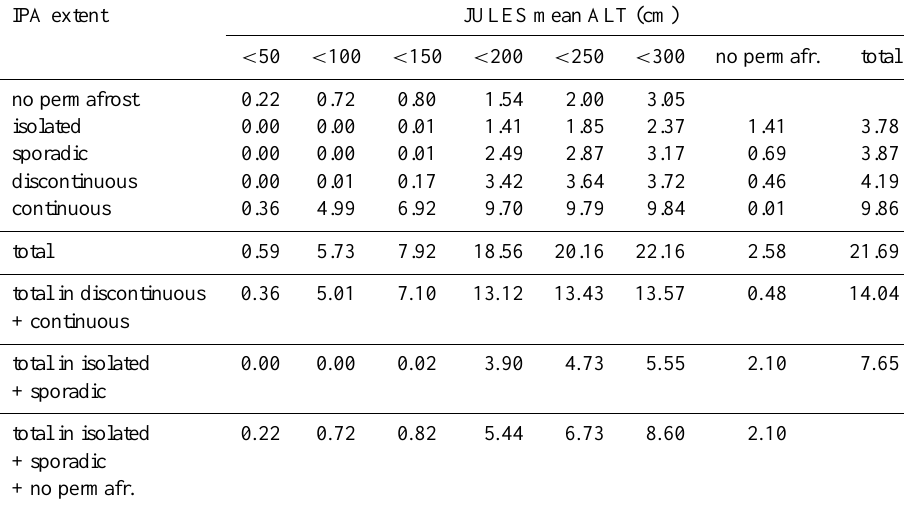
Table 5. Cross-tabulation of permafrost extent classes in the IPA permafrost map (Brown et al., 2001) and JULES mean ALT classes in the GSWP2 run (1983–1995). The table summarises the total area where each IPA extent class (rows) coincides with each JULES ALT class (columns). IPA areas may differ slightly from previously reported estimates (e.g. Zhang et al., 2003) because of regridding and the different land/sea mask in the JULES modelling grid. Values are in million km 2 .